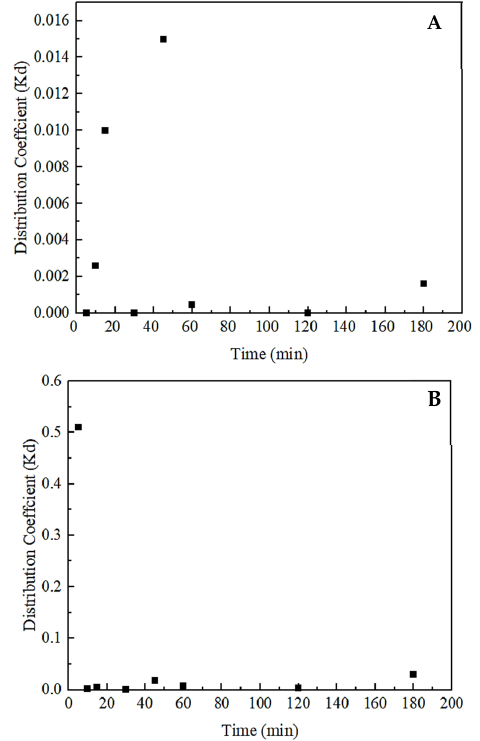
Figure 11. Distribution coefficient values of ( A ) total rare earths and ( B ) thorium as a function of contact time. Error bars represent one standard deviation of multiple replicate